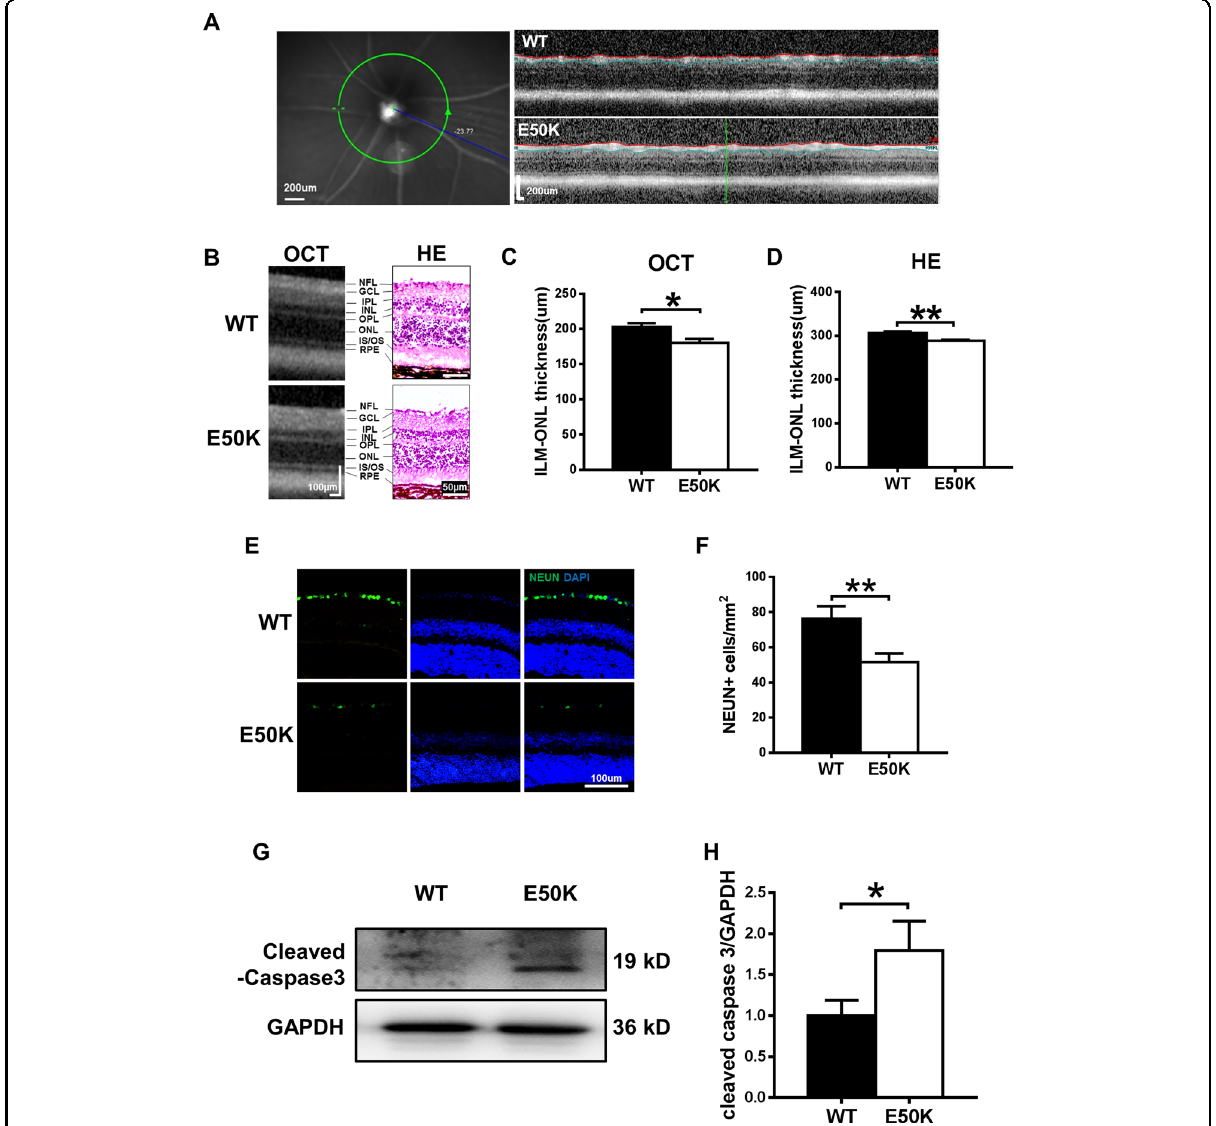
Fig. 2 Comparison of retinal morphology and apoptosis in WT and E50K mutant mice. A Left: example of an SLO image of the central murine retina. Right: example of an OCT slice from WT and E50K mutant mice. B OCT scans and histology of retinal layers. C , D Quanti fi cation of retinal thickness measurements by OCT and histological analysis. For OCT, n = 10; for histology, n = 44/28. E Representative images and F quanti fi cation of viable RGC immunolabelling by NEUN. WT = 76.33 ± 7.000, n = 10; E50K = 51.67 ± 4.846, n = 12. G Caspase-3 protein expression was evaluated by western blot analysis. Representative western blot image and H quanti fi cation of caspase-3 protein expression in WT and E50K mutant mice. n = 4. Data are presented as the means ± SEM; * P < 0.05; ** P <